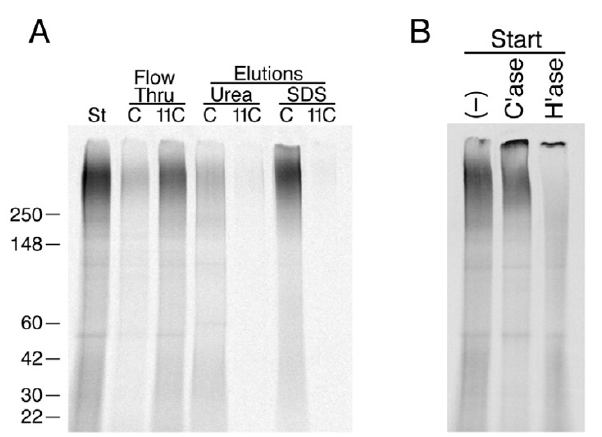
Figure 10 Affinity chromatography HSPGs on III1-C Sepha- rose. RASMCs were collected by trypsinization and lysed in NP40 buffer. The lysate was then treated either without (-) or with (+) 0.1 u/ml heparitinase for 1 hr at 37 ° C. Hepariti- nase treated samples were then applied to either III1-C Sepharose (lanes marked C) or III 11-C Sepharose (lanes marked 11C). One sample was applied to a III1-C Sepharose column in the presence of 0.5 mg/ml heparin (lanes marked C•H). The flow through fractions were collected (FT lanes), the columns were washed extensively, then the Sepharose beads were collected and boiled in SDS-PAGE sample buffer (Bound lanes). Samples were analyzed by immunoblotting with the 3G10 antibody. Antibody 3G10 recognizes the uro- nate stubs that remain associated with core proteins after with similar results both